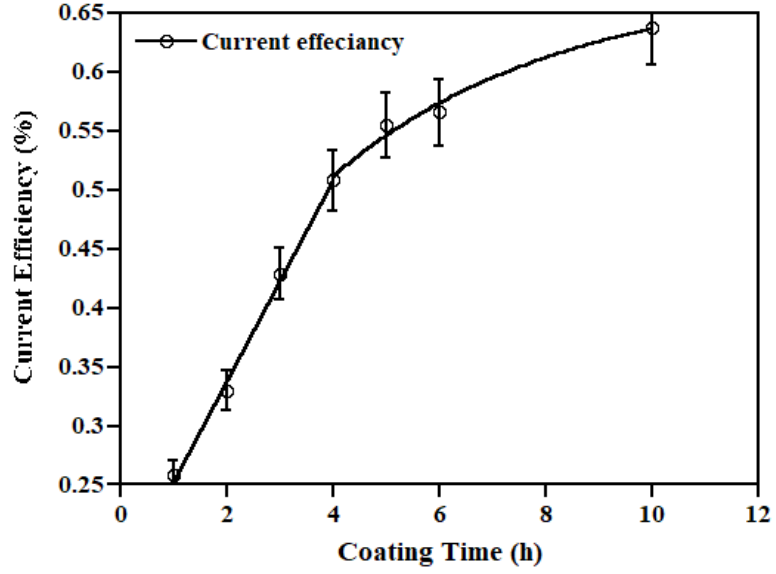
Figure 3. The results of the applied coating weight relative to the initial weight of the foam are plotted as a percentage of the coating application time.